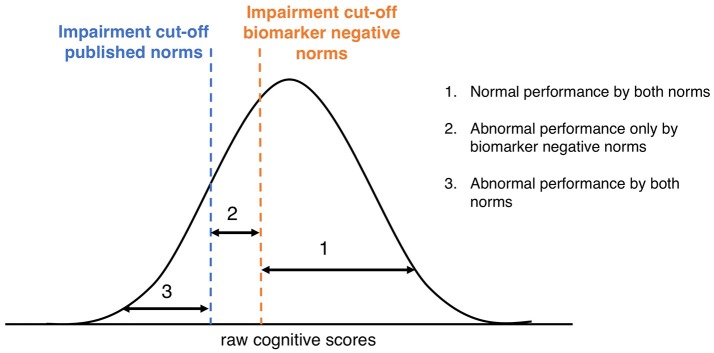
Classification according to published norms and Aβ- norms. Graphical representation of distribution of raw cognitive scores and the different cut-points using published norms or Aβ- norms.